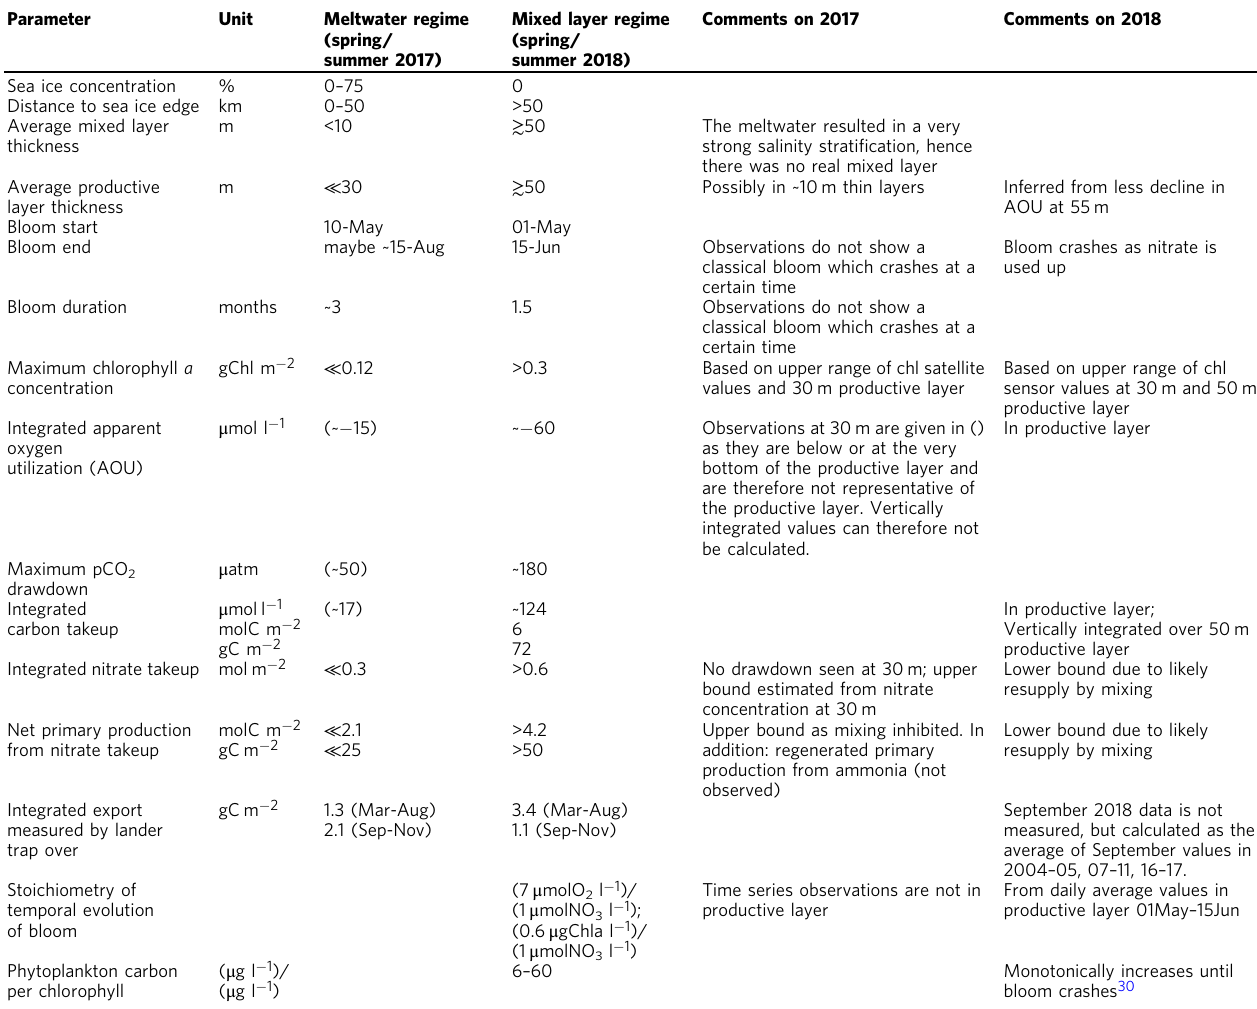
Table 1 Physical and biogeochemical observations over the bloom